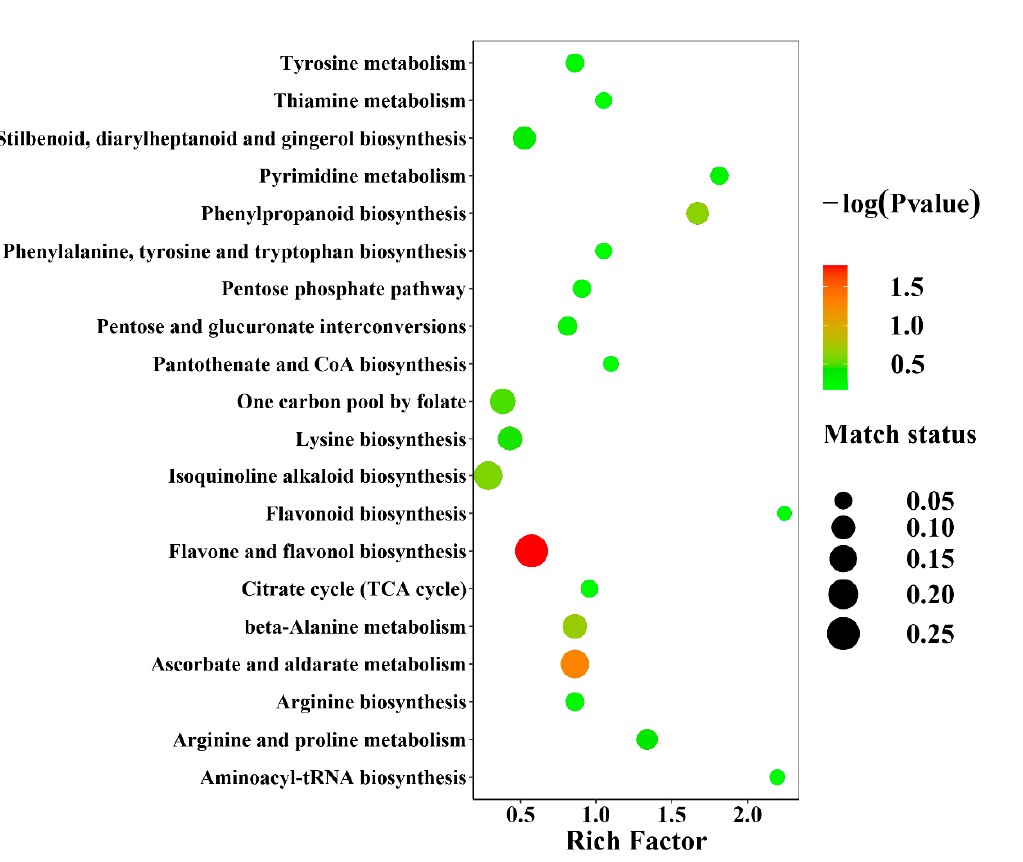
Figure 6. The effects of different cultivation methods on the metabolic pathways. The bubble diagram was used to show the results of KEGG metabolic pathway enrichment analysis. On the left side of the graph, the names of the top twenty enriched metabolic pathways are labeled. The rich factor indicates the degree of enrichment. The color of the dots represents the p -value and the size of the dots represents the amount of metabolites enriched in the pathway.